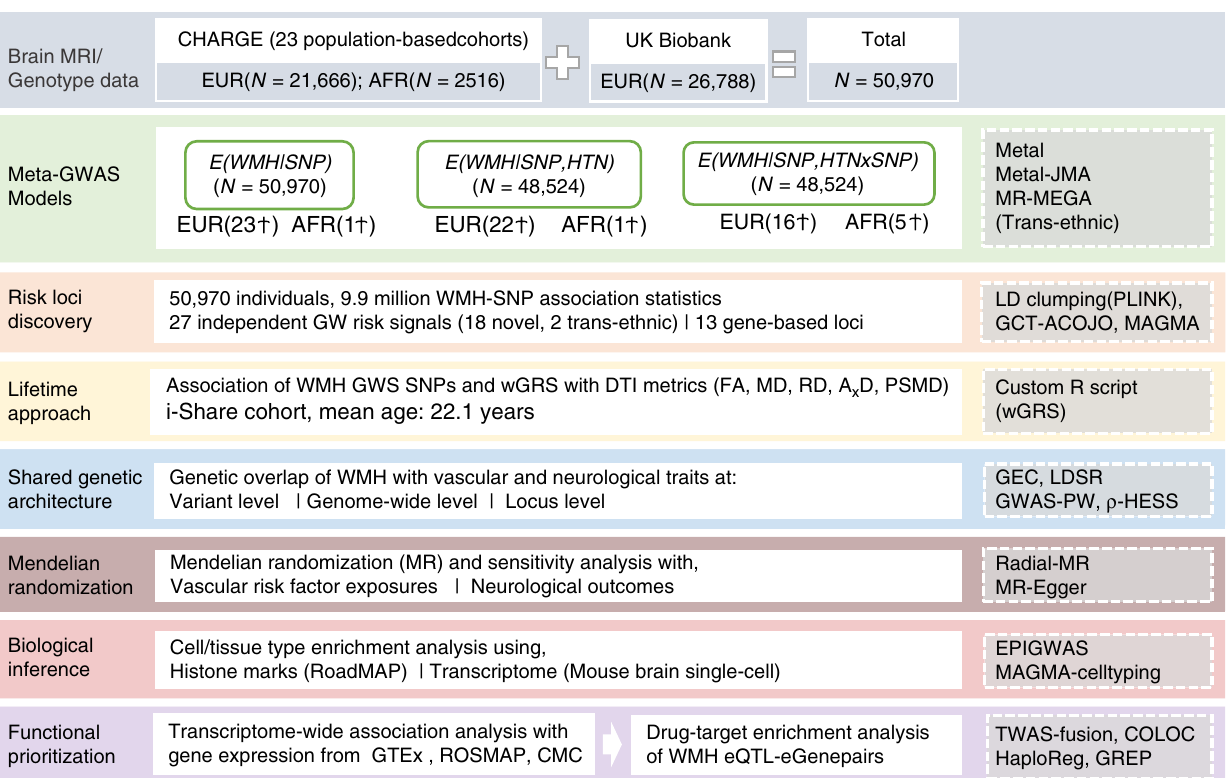
Fig. 1 Study work fl ow and rationale. Ϯ number of GW hits. MRI magnetic resonance imaging, CHARGE cohorts for heart and aging research in genomic epidemiology, EUR European, AFR African – american, GWAS genome-wide association study, WMH White matter hyperintensities, SNP single nucleotide polymorphism, HTN hypertension, JMA joint meta-analysis, MR-MEGA meta-regression of multi-ethnic genetic association, GW genome-wide, LD linkage disequilibrium, GCTA-COJO genome-wide complex trait analysis- conditional and joint analysis, MAGMA multi-marker analysis of genomic annotation, DTI diffusion tensor imaging, iSHARE internet based student health research enterprise, FA fractional anisotropy, MD mean diffusivity, RD radial diffusivity, AxD axial diffusivity, PSMD peak width of skeletonised mean diffusivity, wGRS weighted genetic risk score, GEC genetic type I error calculator, LDSR LD- score regression, GWAS-PW GWAS-pairwise analysis, HESS heritability estimator from summary statistics, EPIGWAS epigenome wide association study, TWAS transcriptome-wide association study, GTEx genotype-tissue expression, ROSMAP religious orders study and the RUSH memory and aging project, CMC common mind consortium, eQTL expression quantitative trait loci, eGene expression-associated genes, COLOC colocalisation, GREP genome for repositioning